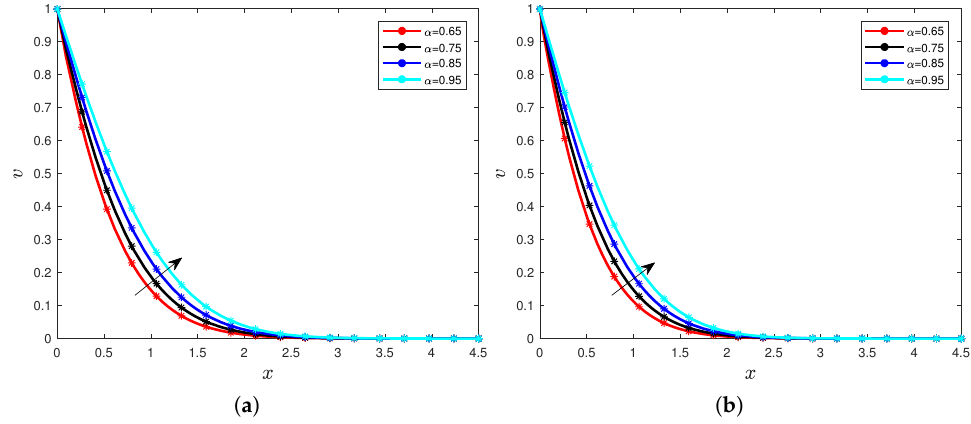
Figure 8. Temperature for different values of the fractional order with Pr = 10 ( a ) and Pr = 15 ( b